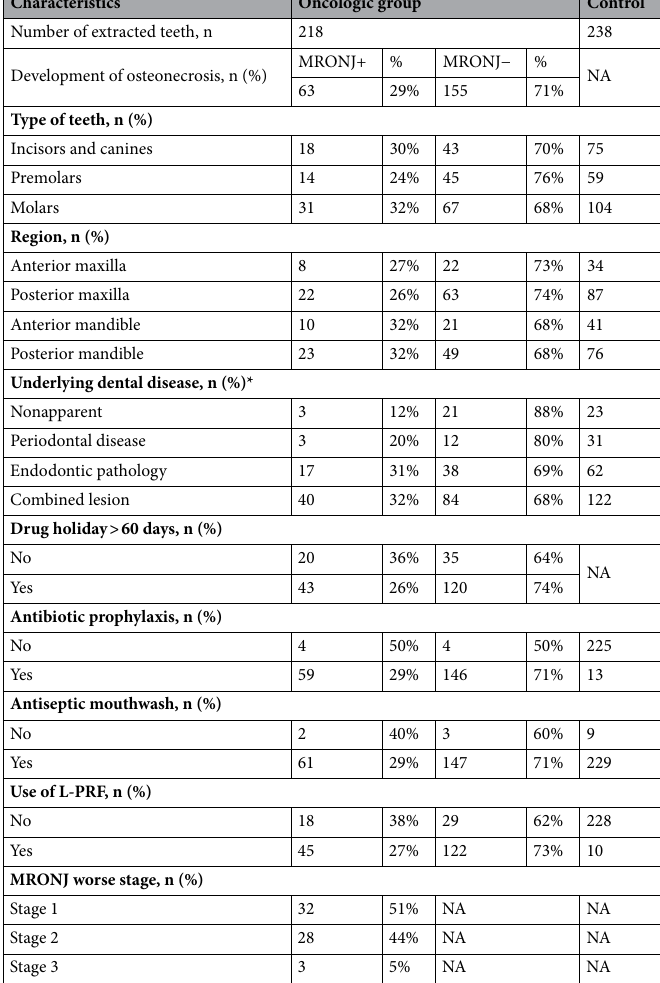
Table 2. Descriptive data of the extracted teeth in the study and control group. Further description of the teeth from the study group that did (MRONJ+) and did not (MRONJ−) develop osteonecrosis is given. NA, not applicable. *Based on the radiographic characteristics, teeth were classified into: periodontally diseased, which had horizontal bone loss, an angular bone defect, or furcation involvement; with endodontic pathology, which presented pulpal caries, widened periodontal ligament space, prosthodontic treatment and concomitant caries, or periapical lesion; and with endodontic-periodontal combined lesions, when presenting characteristics from both